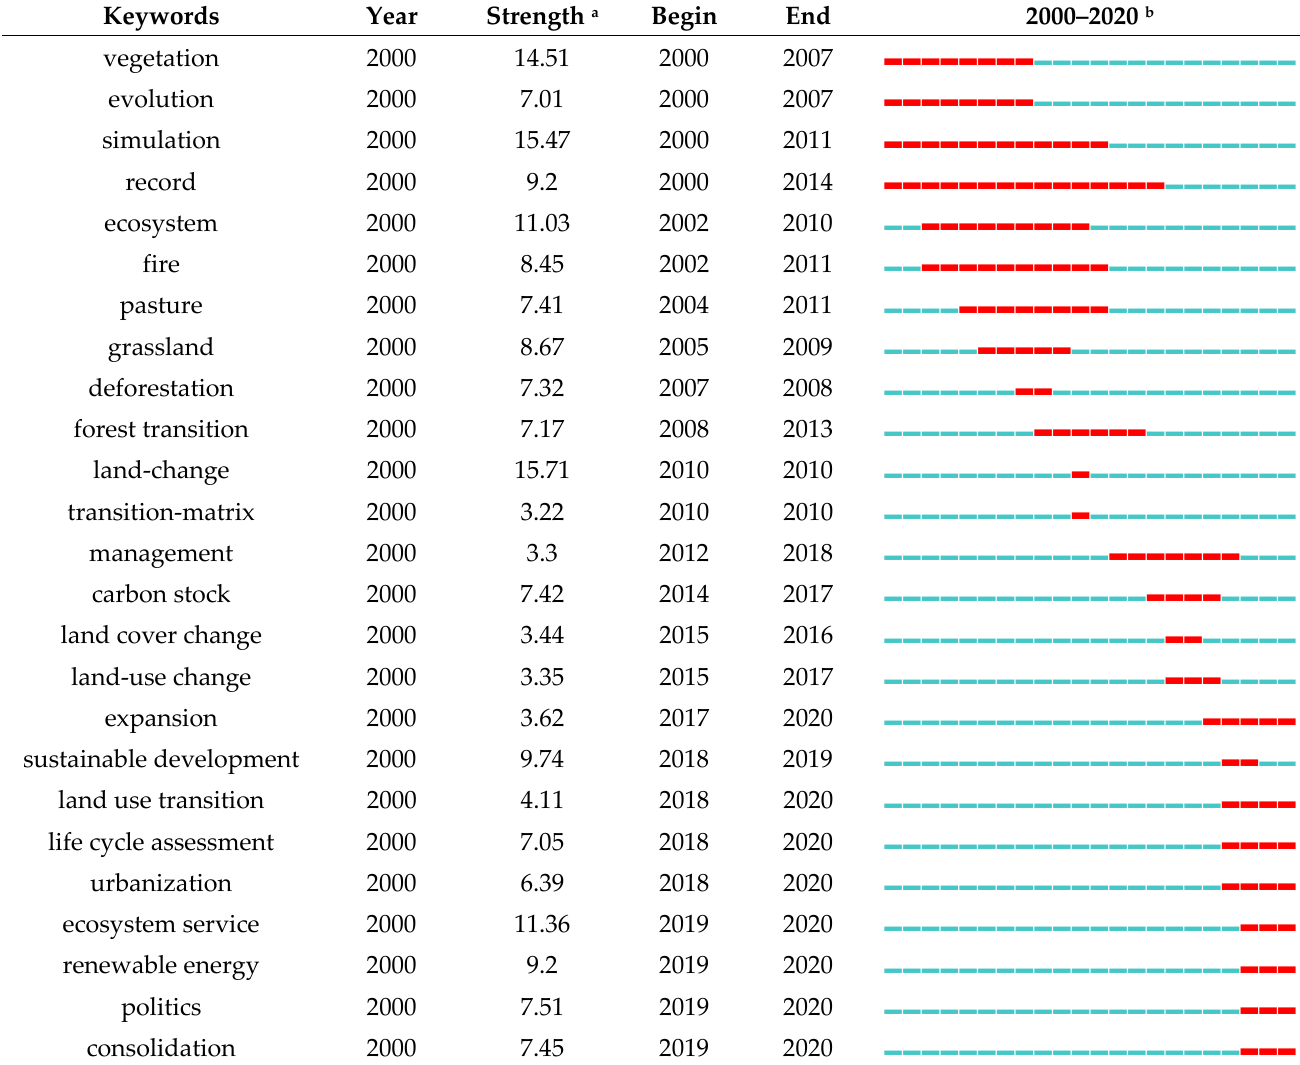
Table 2. Top 25 keywords with the strongest citation bursts during 2000–2020.